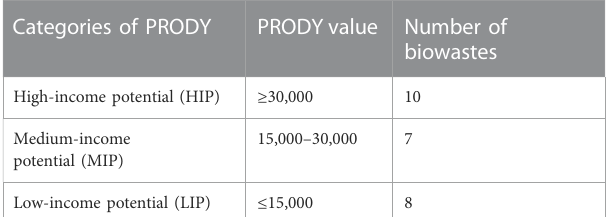
TABLE 4 Biowastes PRODY